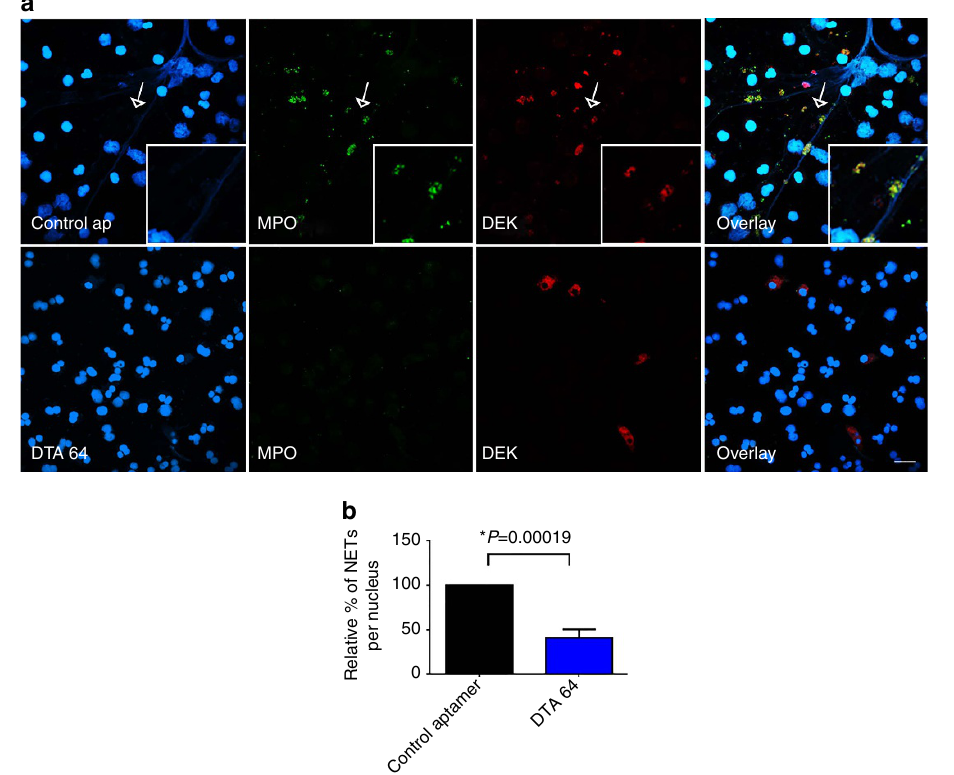
Figure 7 | Neutrophils treated with anti-DEK aptamer (DTA-64) have fewer NET structures and show retention of intracellular DEK. ( a ) Peripheral blood human neutrophils were obtained from healthy donors and plated on glass coverslips. Control or anti-DEK aptamers (DTA-64) were added to neutrophil cultures 15min prior to PMA stimulation (10ngml (cid:2) 1 ). Neutrophils were incubated for 1h at 37 (cid:2) C, then fixed and stained for NETs with anti-MPO (green), DAPI for DNA (blue) and DEK (red) as shown in representative confocal images from experiments using 5ngml (cid:2) 1 of control aptamer or DTA-64 ( (cid:3) 60 magnification, scale bar 20 m m). The inserts zoom in on the NETs marked by the arrows in the upper panel. ( b ) NETstaining